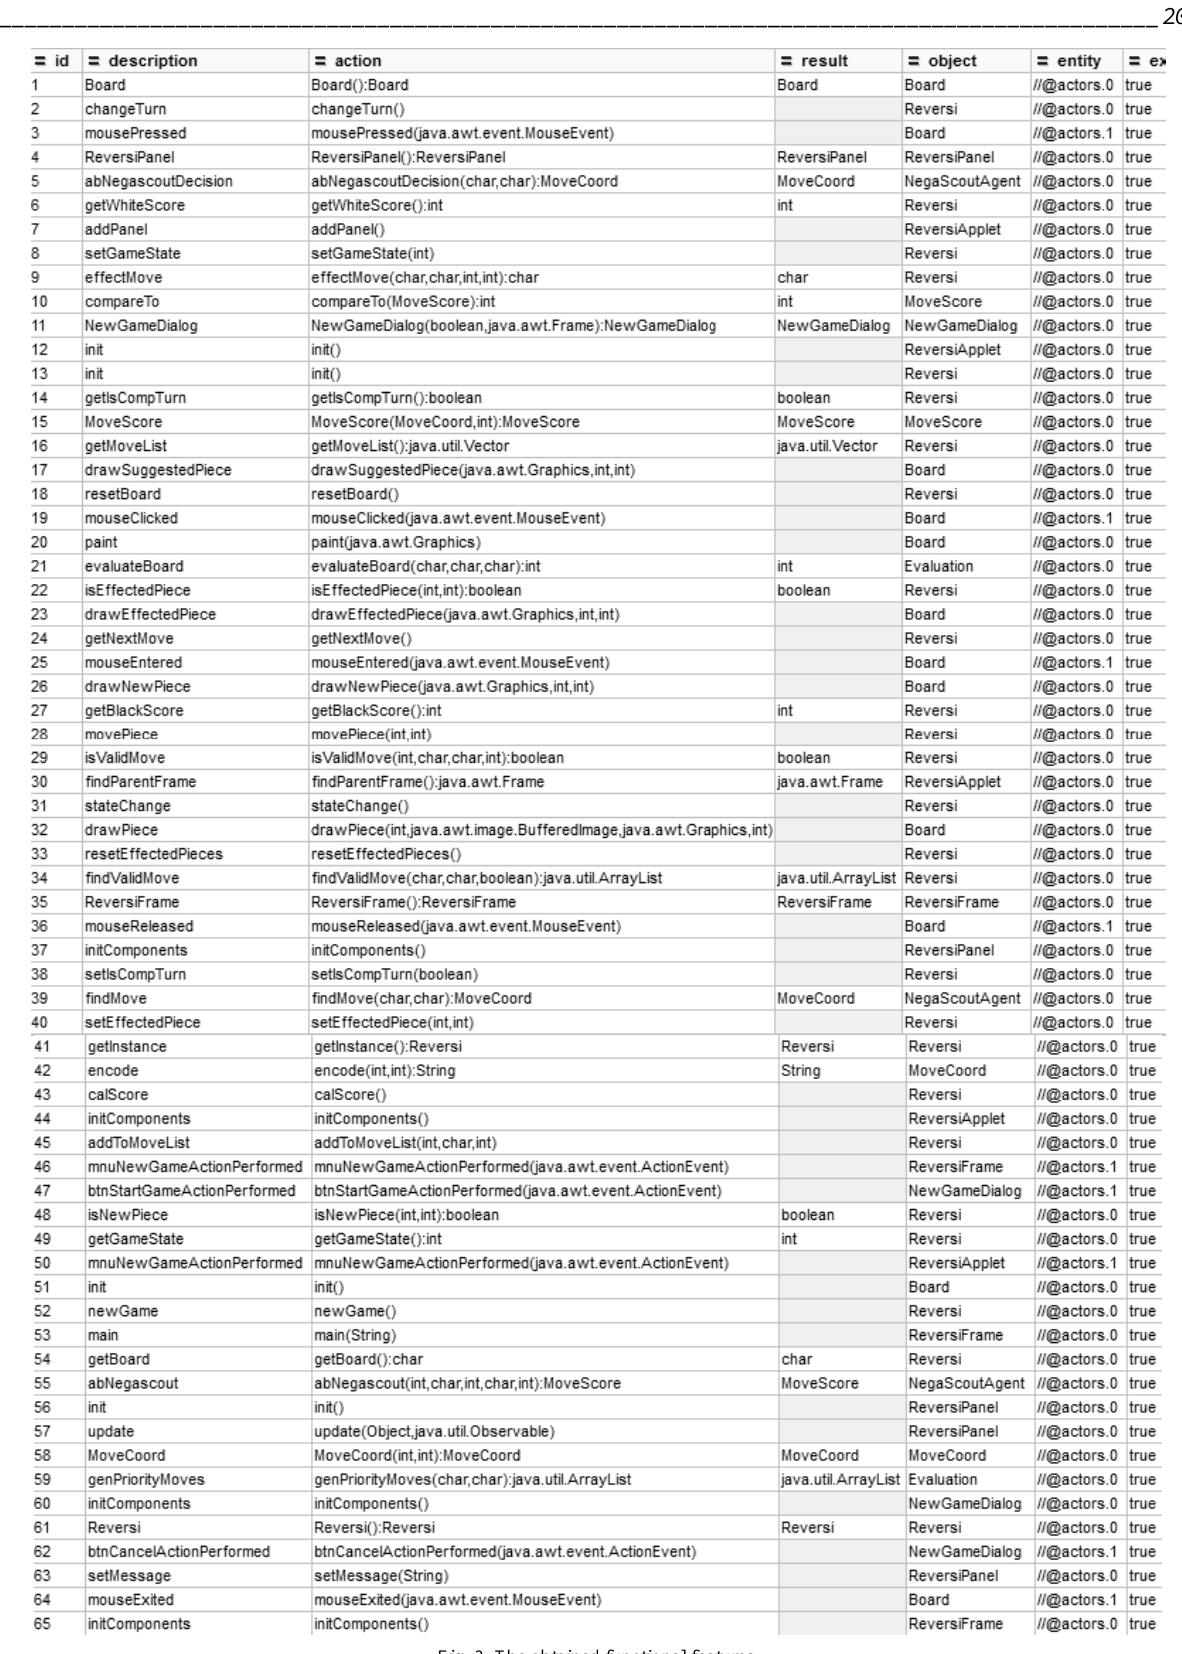
Fig. 3. The obtained functional